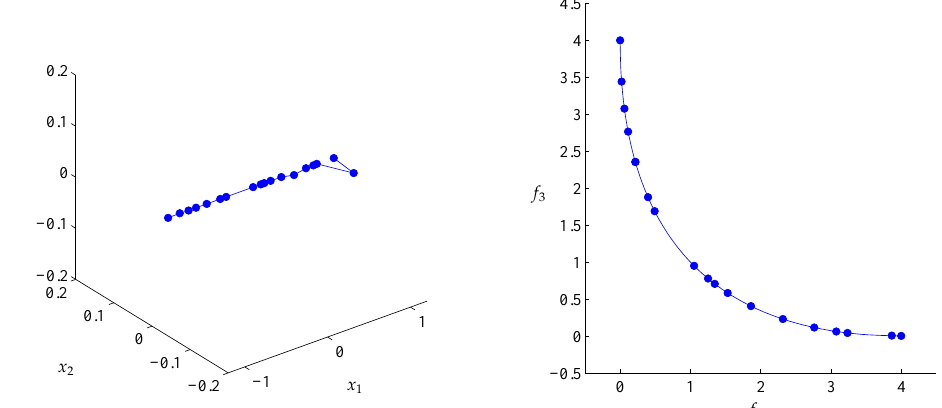
1 0 −1 Figure 16. Left: Approximations A (blue dots) and B (blue continuous polygon line) of the Pareto set of MOP (14) in the 400th generation. Right: corresponding approximations F ( A ) and F ( B ) of the Pareto front.